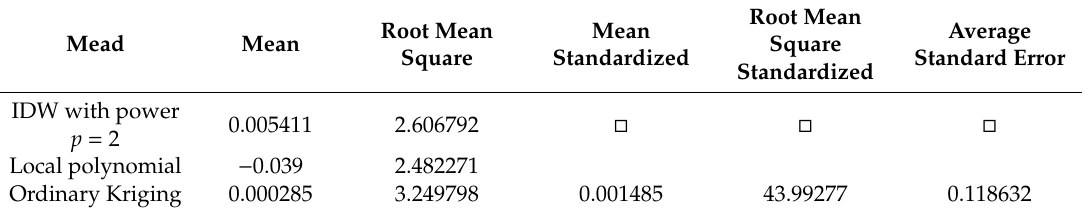
Table 2. Descriptive statistics in cross-validation of the ice thickness